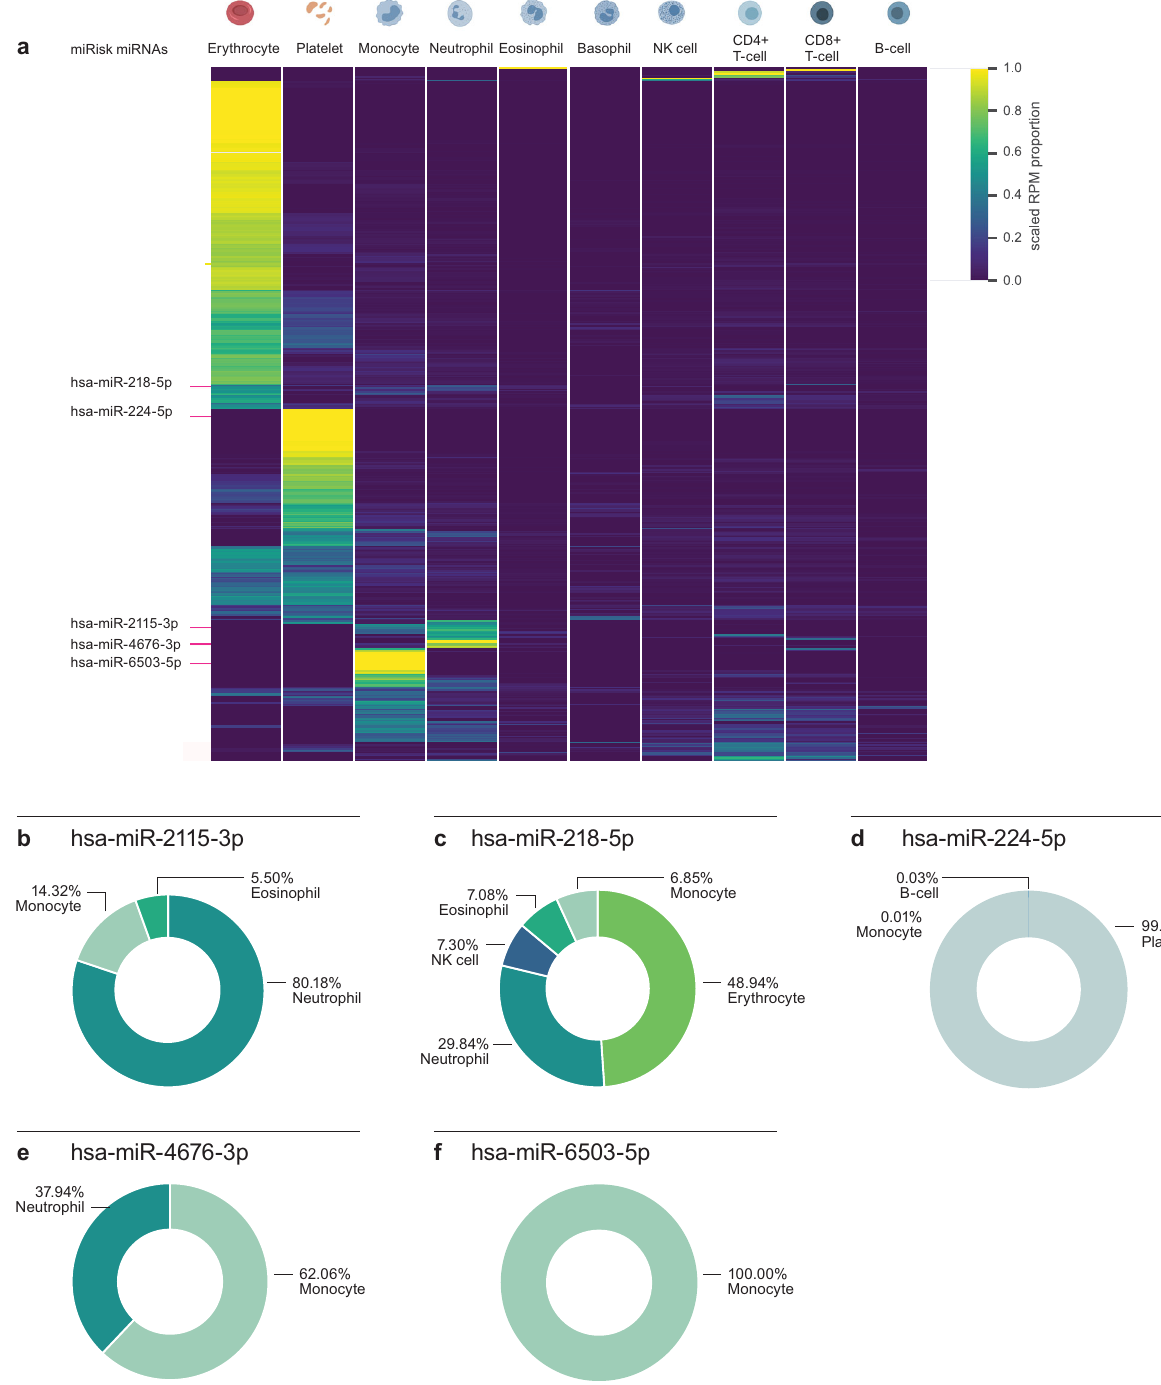
Fig. 4 Cellular origin of miRisk miRNAs in peripheral whole blood. a Relative distribution of PAXgene detected miRNAs across 10 puri fi ed cell types. The 5 miRisk miRNAs are indicated. b – f The relative contributions and cellular origin of the 5 miRisk miRNAs. miRNA RPM values were scaled by cell-type-speci fi c small RNA content per cell and abundance in blood. Per miRNA the scaled values of all measured cell types were indexed to 100%. RPM reads per